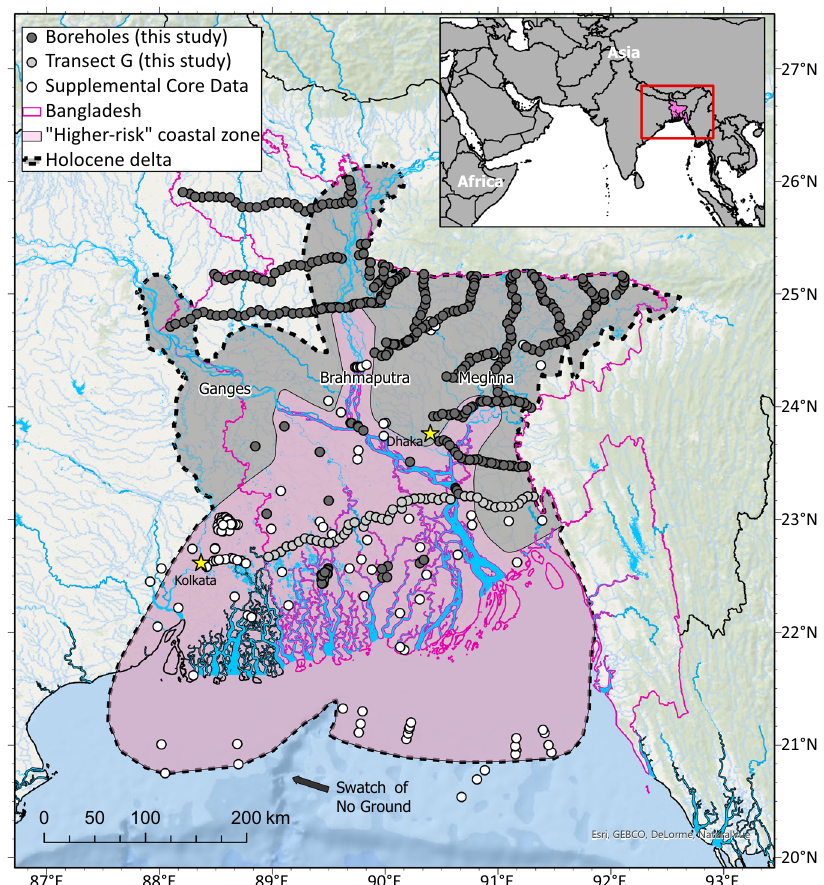
Fig. 1 | Map of the Bengal basin and the Ganges – Brahmaputra River delta in South Asia showing the study area and and drilling/sampling and data loca- tions. The delta and lower Ganges and Brahmaputra rivers are located in Bangla- desh and West Bengal, India. The Holocene delta developed on an incised Pleistocene surface and the boundary of Holocene deposits is shown by the black dashed line. The subaqueous portion of the Holocene delta is located on the shelf and bordered by the Swatch of No Ground canyon and Bay of Bengal to the south. Over 450 boreholes from this study are denoted by the dark and light gray – fi lled circles 108,131,132 , with the light gray circles demarking Transect G cores shown in